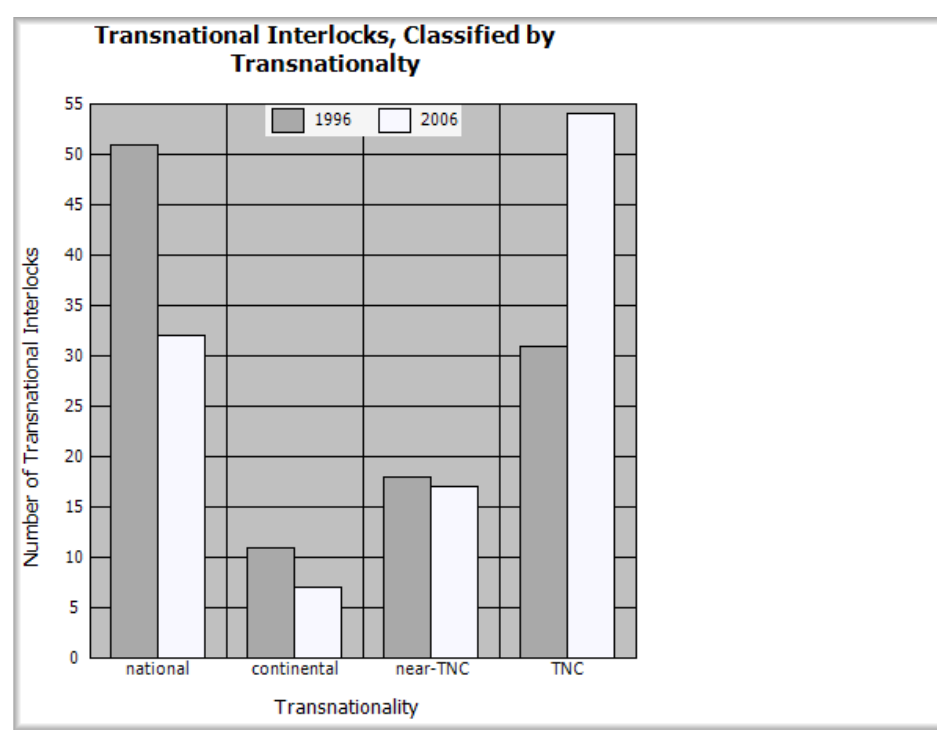
Figure 4. Transnational Interlocks Classified by Transnationality, 1996 and